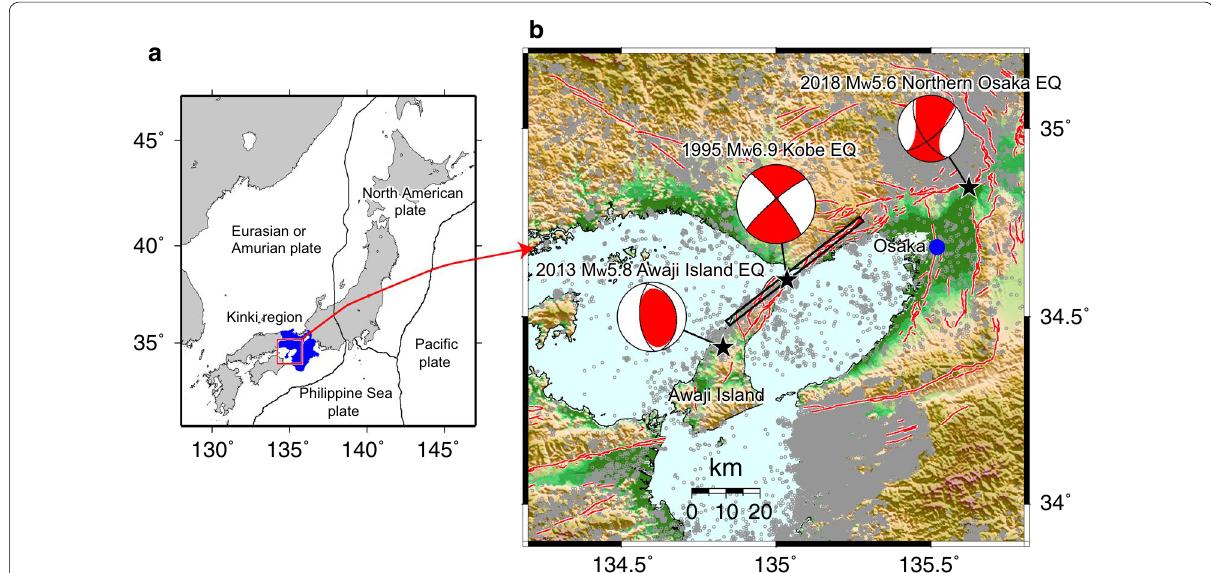
Fig. 1 Map showing study area. a Tectonic setting of Japanese islands. The Kinki region, which includes Awaji Island, is shown in blue. b Enlarged map of red rectangle shown in a depicting the 2013 M w 5.8 Awaji Island earthquake. Red lines show active faults after Nakata and Imaizumi (2002). Circles represent M0 seismicity shallower than 20 km determined by the Japan Meteorological Agency (JMA) during the period from 1 January + 2003 to 12 April 2013 (i.e., the day before the Awaji Island earthquake). The ‘beach balls’ represent the centroid moment tensor solutions by JMA. The surface projection of the fault model of the Kobe earthquake (Ide and Takeo 1997) is indicated by a rectangle. Topography is based on a 250 m grid digital elevation model published by the Geospatial Information Authority of